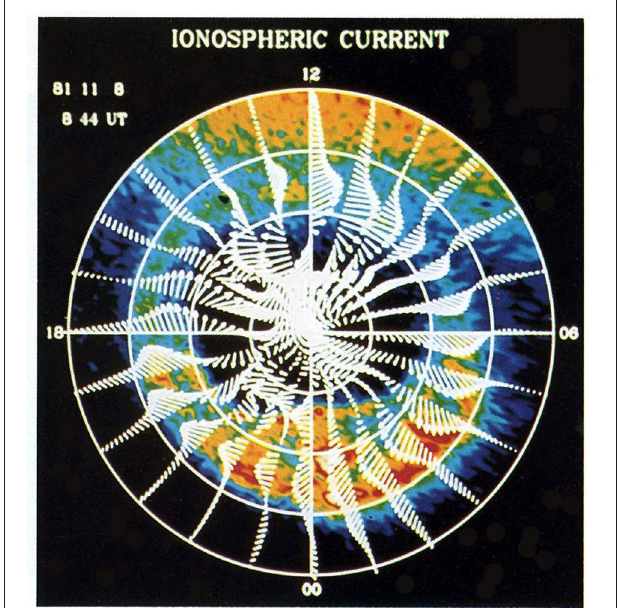
FIGURE 8 | The ionspheric current distribution deduced from ground-based magnetometer network. The simultaneous auroral image obtained by a satellite is superposed ( Craven et al., 1984). A strong current, called the “auroral electrojet,” flows along the oval. Both the electrojet and the aurora advanced poleward as far as 78 ◦ gm. lat. during this expansion